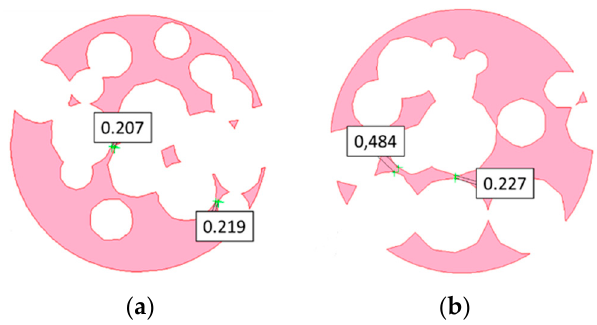
Figure 11 . Virtual transverse cross-sections at ( a ) 10 mm and ( b ) 25 mm height.